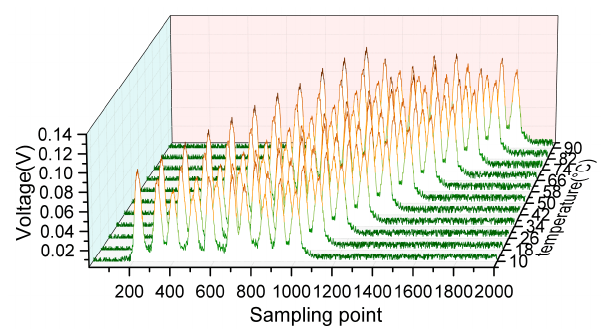
Figure 8. Reflected waveforms from 10 FBGs at different temperature.